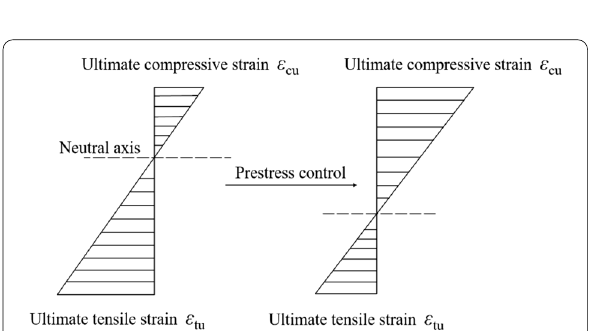
Fig. 15 The strain distribution of the beam at the mid-span